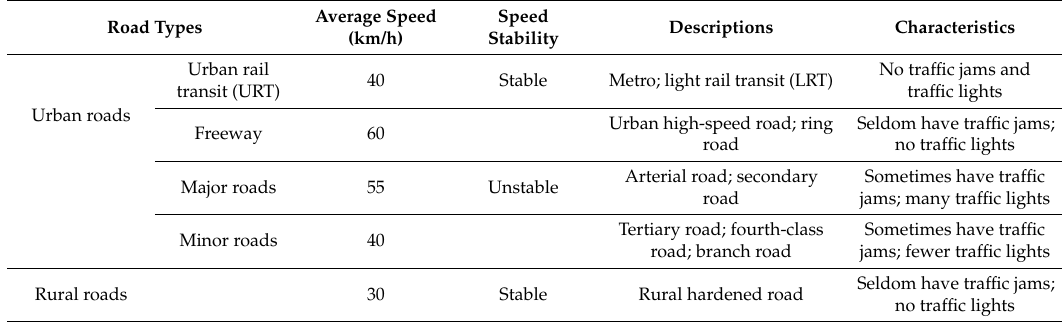
Table 1. Speed stability and characteristics of different road types in Wuhan,